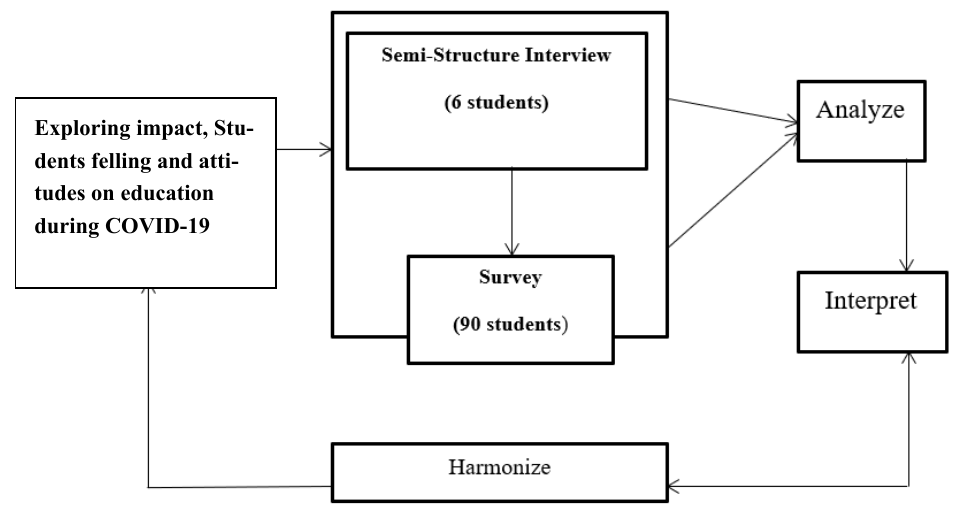
Figure 1. The research data sources and methods.